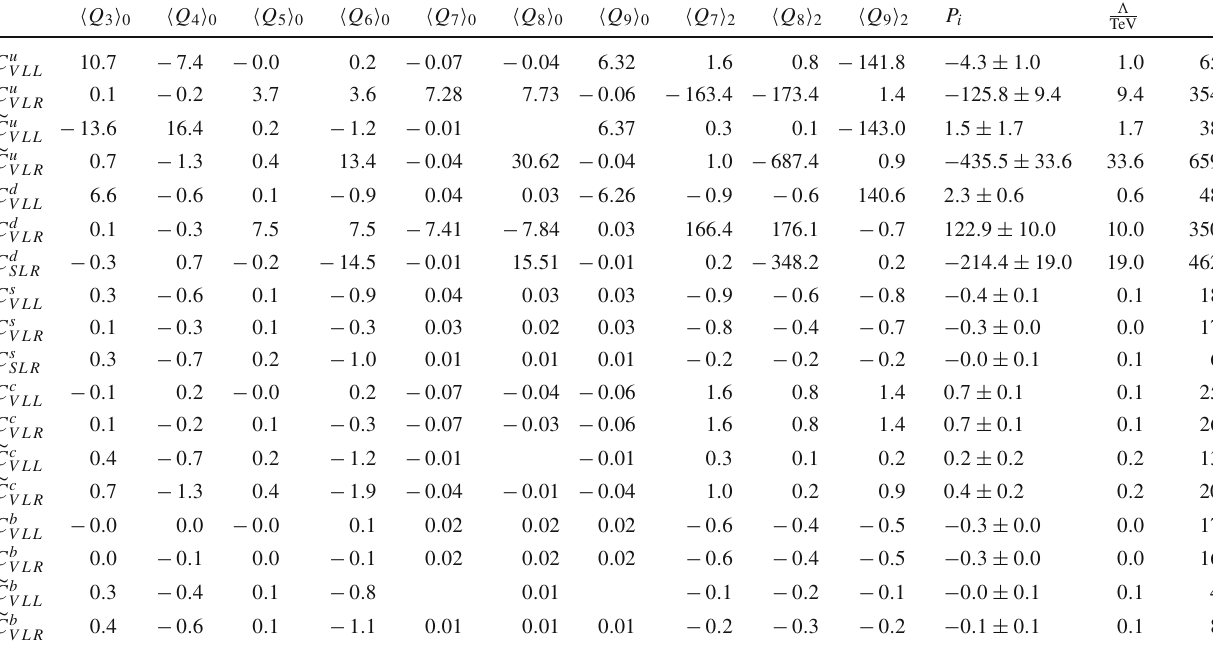
Table 6 Coefficients p ( I ) and P i of the master formula (18)–(19) as well as suppression scale (cid:8) (last column) from Wilson coefficients of operators ij in Class A multiplying SM matrix elements only. Empty entries correspond to coefficients < 0 . 05